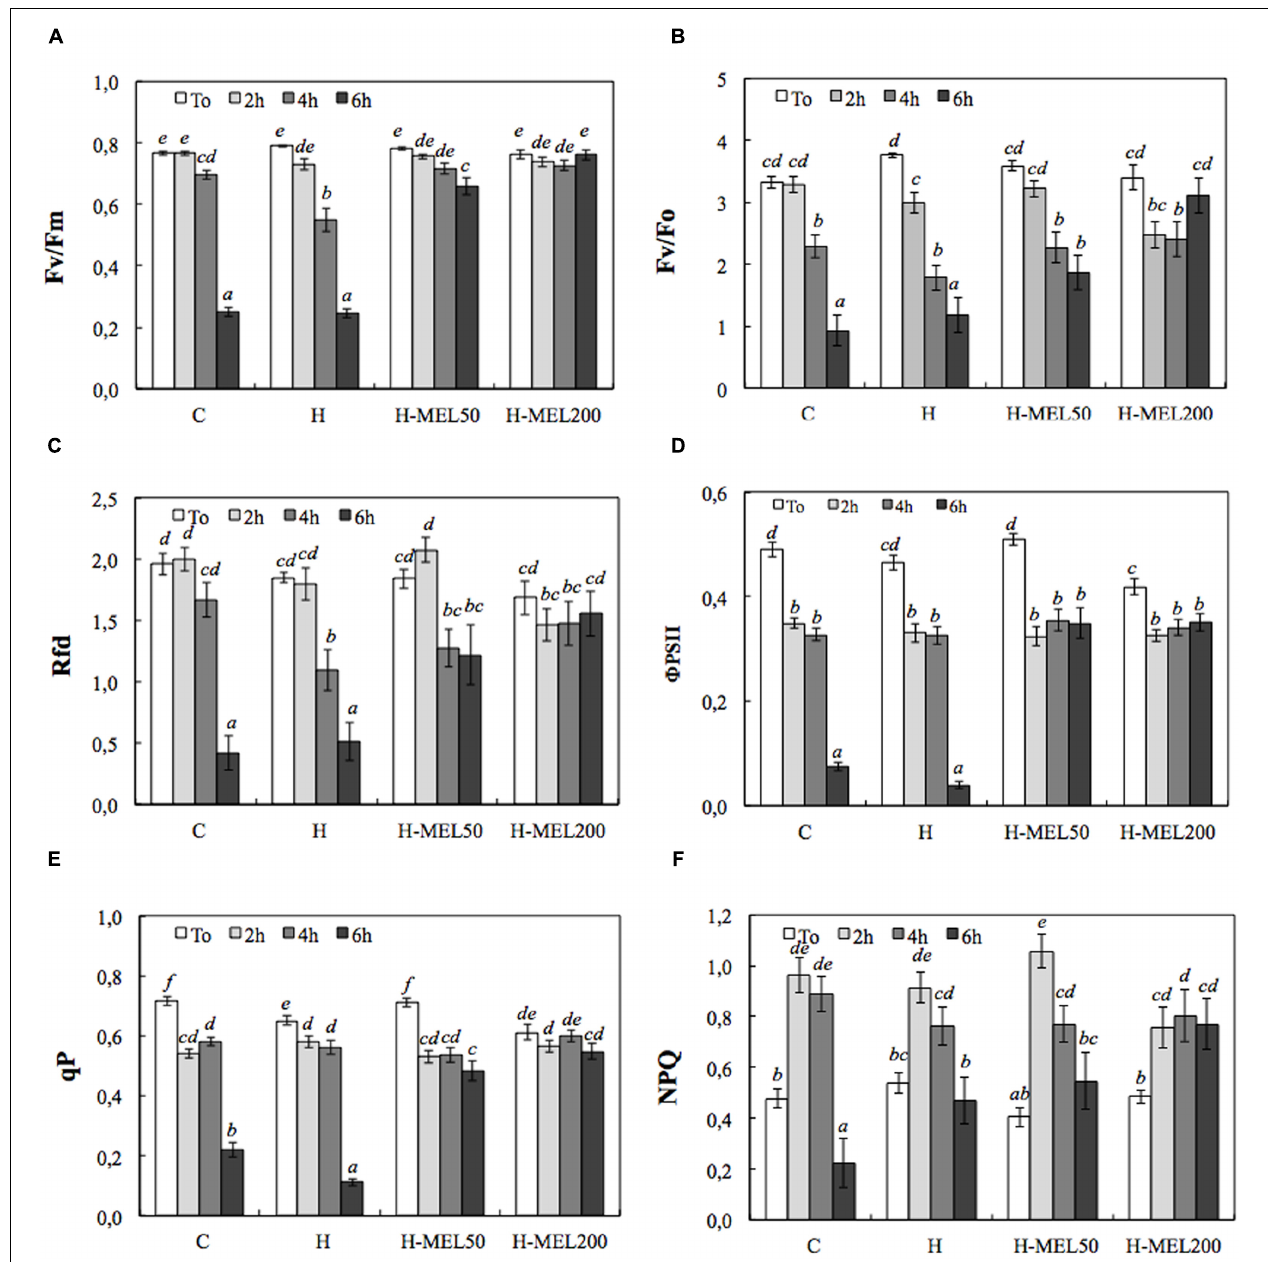
FIGURE 1 | Chlorophyll fluorescence parameters of leaf disks cut out of 24-day-old pea plants grown from the control (C), hydroprimed (H), and hydroprimed with an aqueous solution of 50 µ M melatonin (H-MEL50) or 200 µ M melatonin (H-MEL200) seeds. Measurements were performed at T 0 (before PQ treatment) and after 2, 4, and 6 h of disk incubation in 75 µ M PQ solution. Individual graphs show: (A) maximum photochemical quantum yield of PSII in the dark-adapted state ( F v / F m ); (B) the efficiency of the water-splitting complex on the donor side of PSII ( F v / F 0 ); (C) vitality index (Rfd); (D) quantum efficiency of PSII ( (cid:56) PSII); (E) photochemical quenching (qP), (F) non-photochemical quenching (NPQ). The results are expressed as mean values of about 25 measurements ± SEM. Two-way ANOVA and Duncan’s post hoc test were performed. The small letters on the graphs show statistical significance. ANOVA results: F v / F m – Variant (C, H, H-MEL50, and H-MEL200) F ( 3 , 331 ) = 87.4 p < 0.0001; Time ( T 0 , 2, 4, and 6h) F ( 3 , 331 ) = 217 p < 0.0001; and interaction Variant × Time F ( 9 , 331 ) = 53.4 p < 0.0001; F v / F 0 – Variant (C, H, H-MEL50, and H-MEL200) F ( 3 , 376 ) = 3.77 p < 0.01; Time ( T 0 , 2, 4, and 6 h) F ( 3 , 376 ) = 52.2 p < 0.0001; and interaction Variant × Time F ( 9 , 376 ) = 7.2 p < 0.0001; Rfd – Variant (C, H, H-MEL50, and H-MEL200) F ( 3 , 359 ) = 3.31 p < 0.01; Time ( T 0 , 2, 4, and 6 h) F ( 3 , 359 ) = 36.5 p < 0.0001; and interaction Variant × Time F ( 9 , 359 ) = 6.2 p < 0.0001; (cid:56) PSII – Variant (C, H, H-MEL50, and H-MEL200) F ( 3 , 296 ) = 27.4 p < 0.0001; Time ( T 0 , 2, 4, and 6 h) F ( 3 , 296 ) = 152.2 p < 0.0001; and interaction Variant × Time F ( 9 , 296 ) = 24.1 p < 0.0001; qP – Variant (C, H, H-MEL50, and H-MEL200) F ( 3 , 296 ) = 21.3 p < 0.0001; Time ( T 0 , 2, 4, and 6 h) F ( 3 , 296 ) = 156 p < 0.0001; and interaction Variant × Time F ( 9 , 296 ) = 25.9 p < 0.0001; NPQ – Variant (C, H, H-MEL50, and H-MEL200) F ( 3 , 294 ) = 0.66 p = 0.5; Time ( T 0 , 2, 4, and 6 h) F ( 3 , 294 ) = 38.1 p < 0.0001; and interaction Variant × Time F ( 9 , 294 ) = 4.27 p <